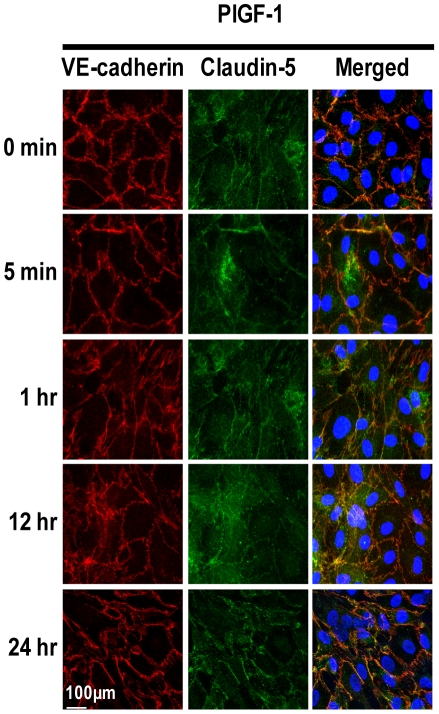
PlGF-1 alone stabilizes AJs in microvascular endothelial cells.Representative pictures of confluent cultures of microvascular endothelial cells treated with hPlGF-1 alone (100 ng/ml) stained for VE-cadherin (red), claudin-5 (green) and nuclei (DAPI) and assessed at different times over 24 hours using confocal microscopy. Scale bar = 100 µm.